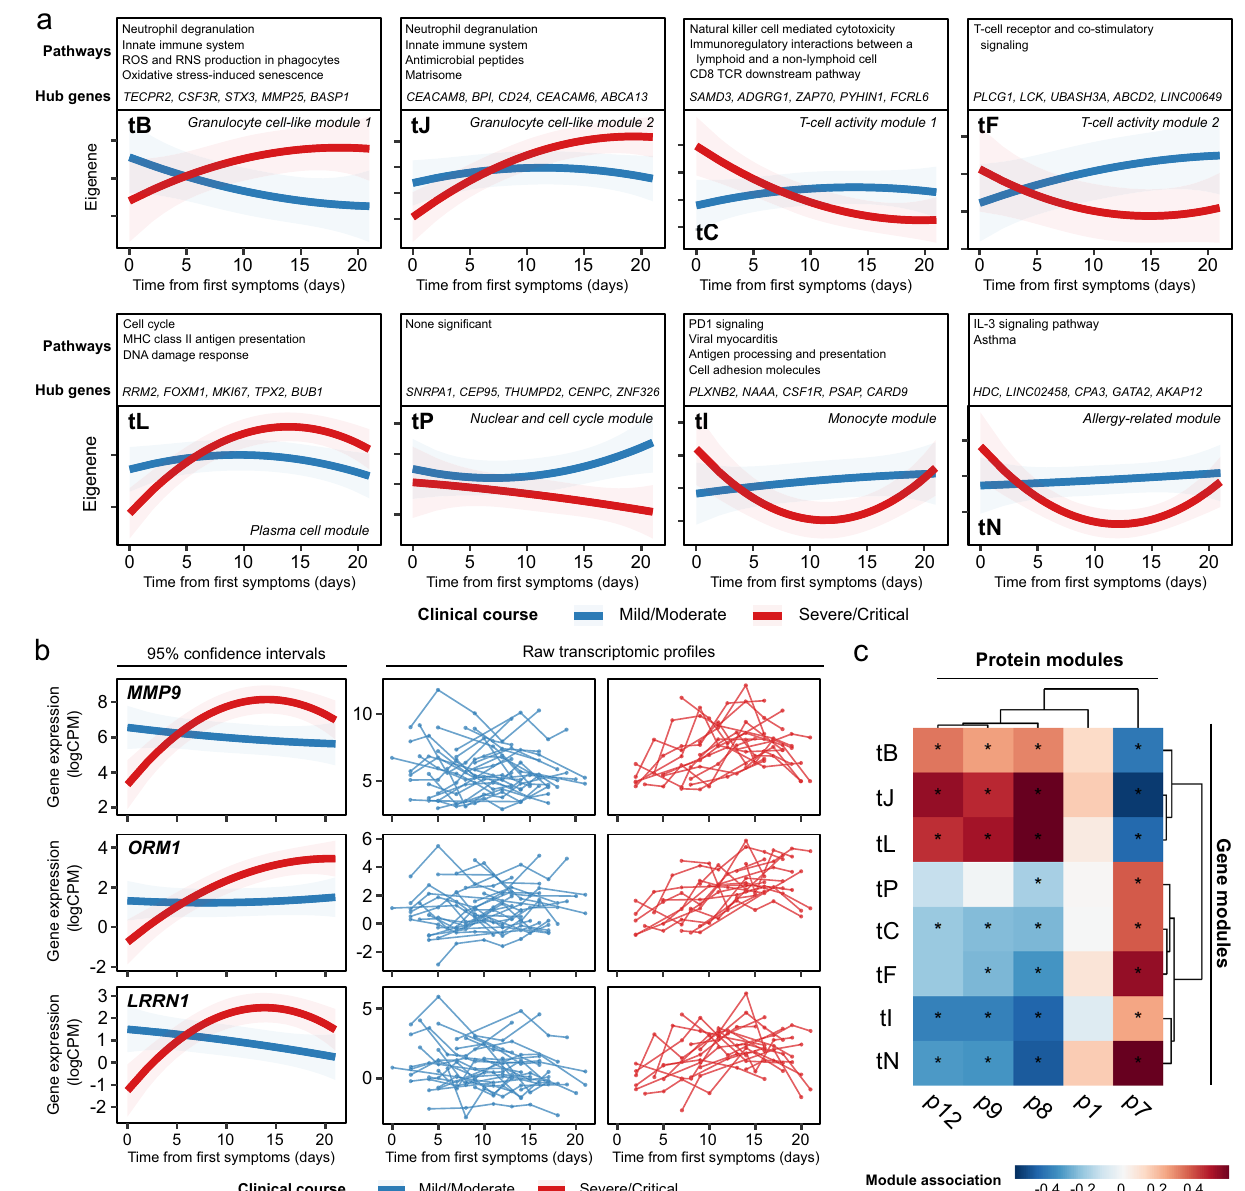
-0.4 -0.2 0 0.2 0.4 represent estimated marginal means and shaded areas represent their 95% con- fi denceintervals.Right:individual-leveldata( n =169samplesfrom40individuals). c Heatmap displaying associations (LMM) between transcriptomic and proteomic modules (right). Red=positive correlation, blue=negative correlation. Signi fi cant associations (5% FDR) are represented by an